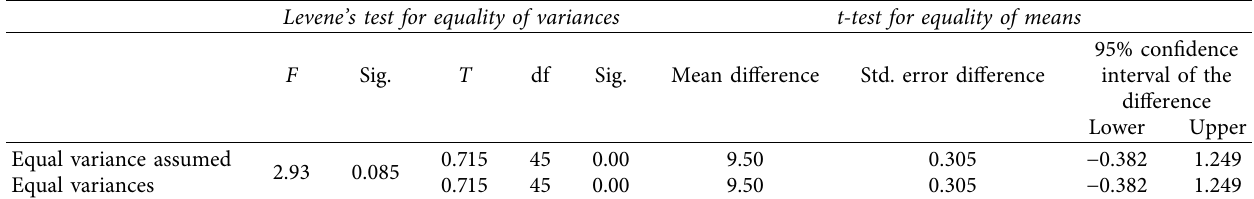
Table 10: Independent samples t -test for the experimental and control groups.